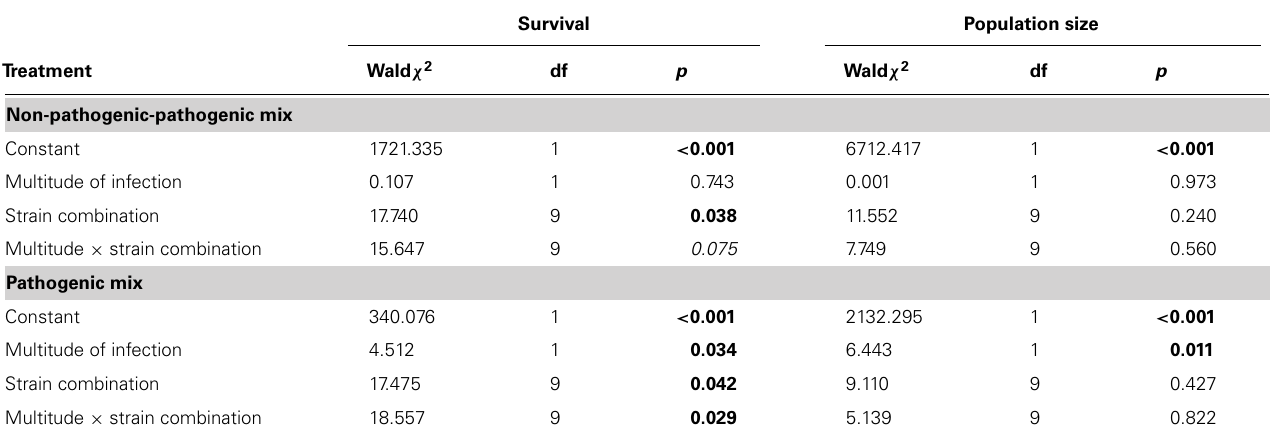
Table 3 | Statistical results of the generalized linear model testing for a genotype-specific difference between single and multiple infections using multitude of infection (mean of single infections versus mixed infection), strain combination and the interaction between both as fixed